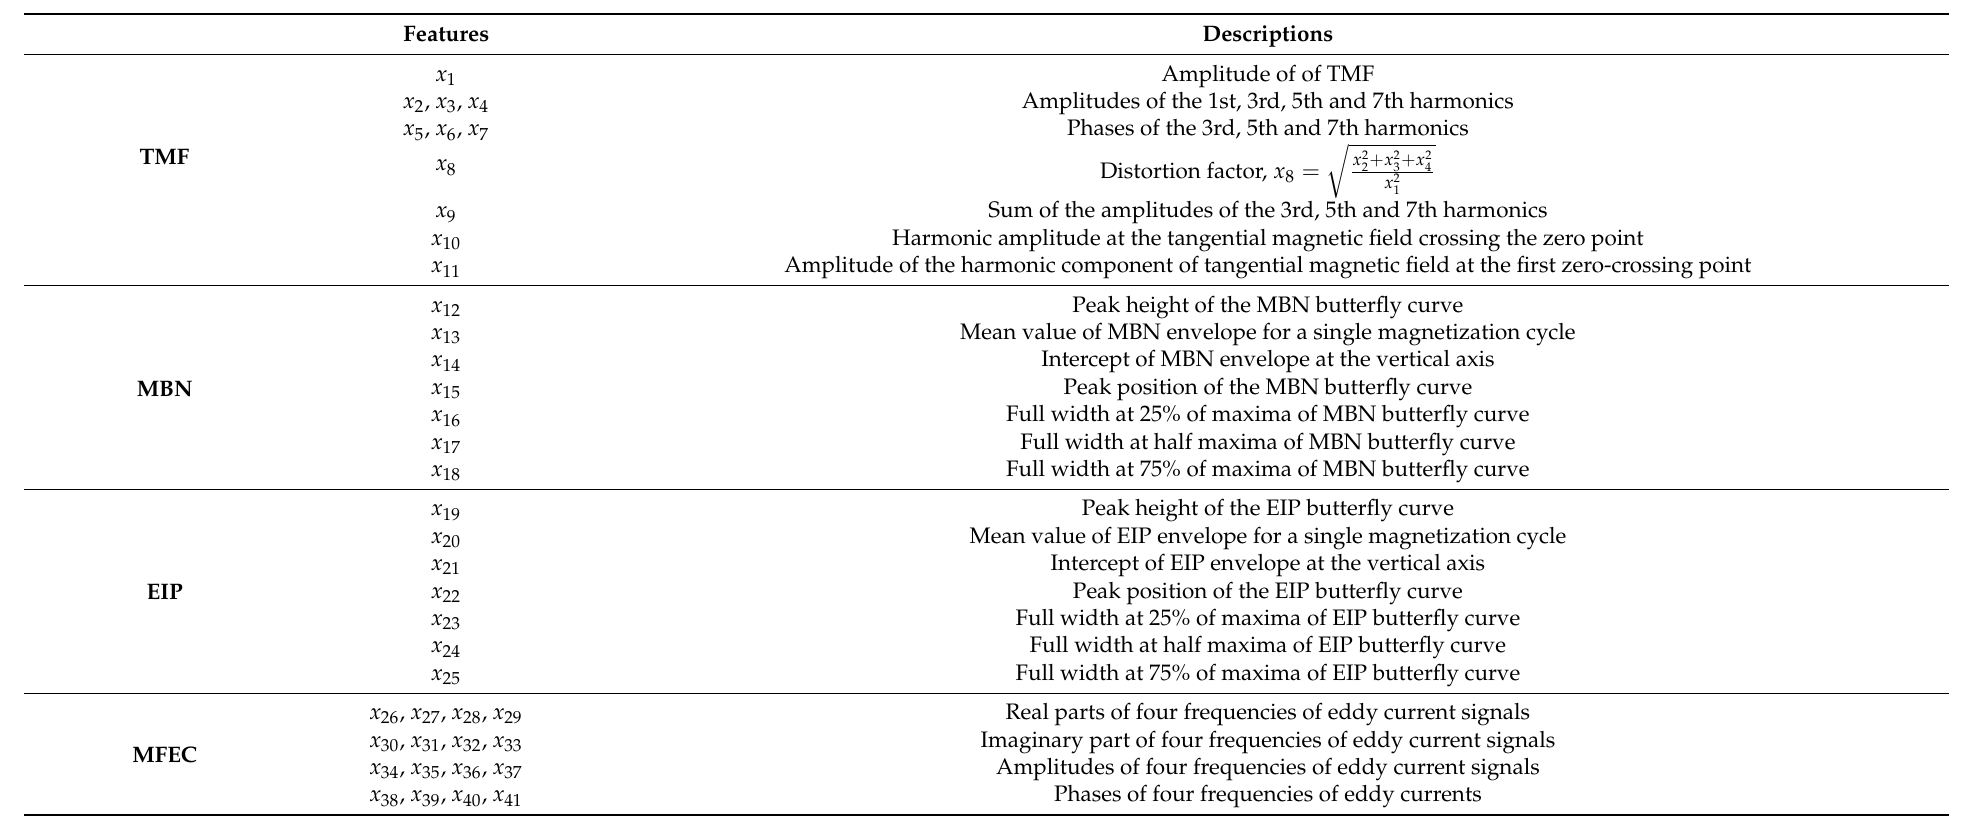
Table A1. Features extracted from the four types of magnetic